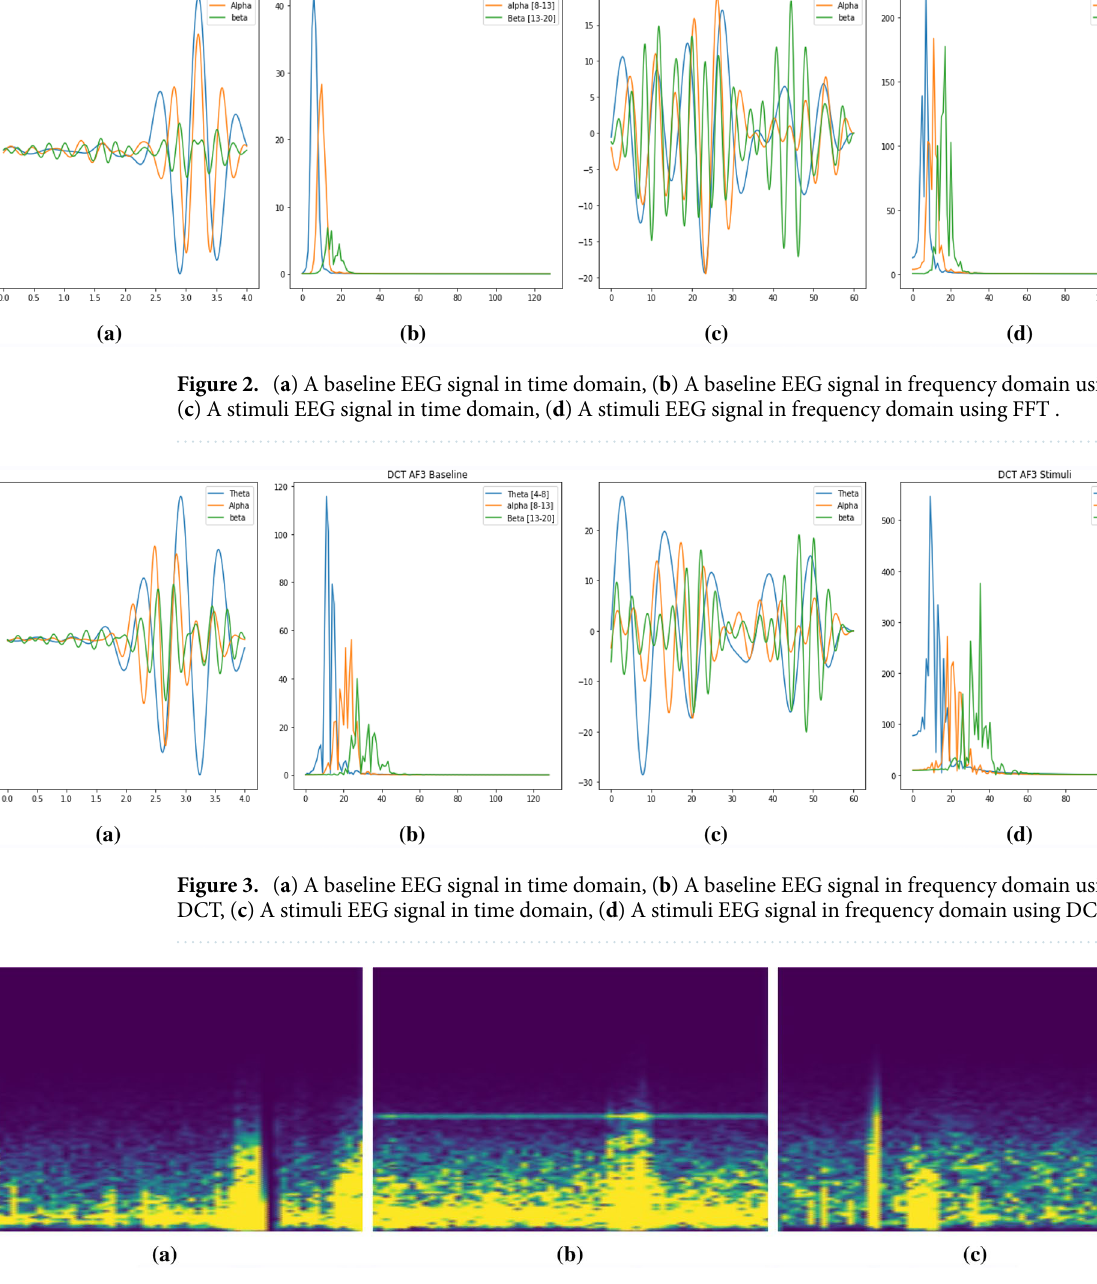
Figure 4. EEG signal spectrograms using STFT with classification ( a ) high arousal, high valence, and low dominance, ( b ) low arousal, high valence, and high dominance, ( c ) high arousal, low valence, and low